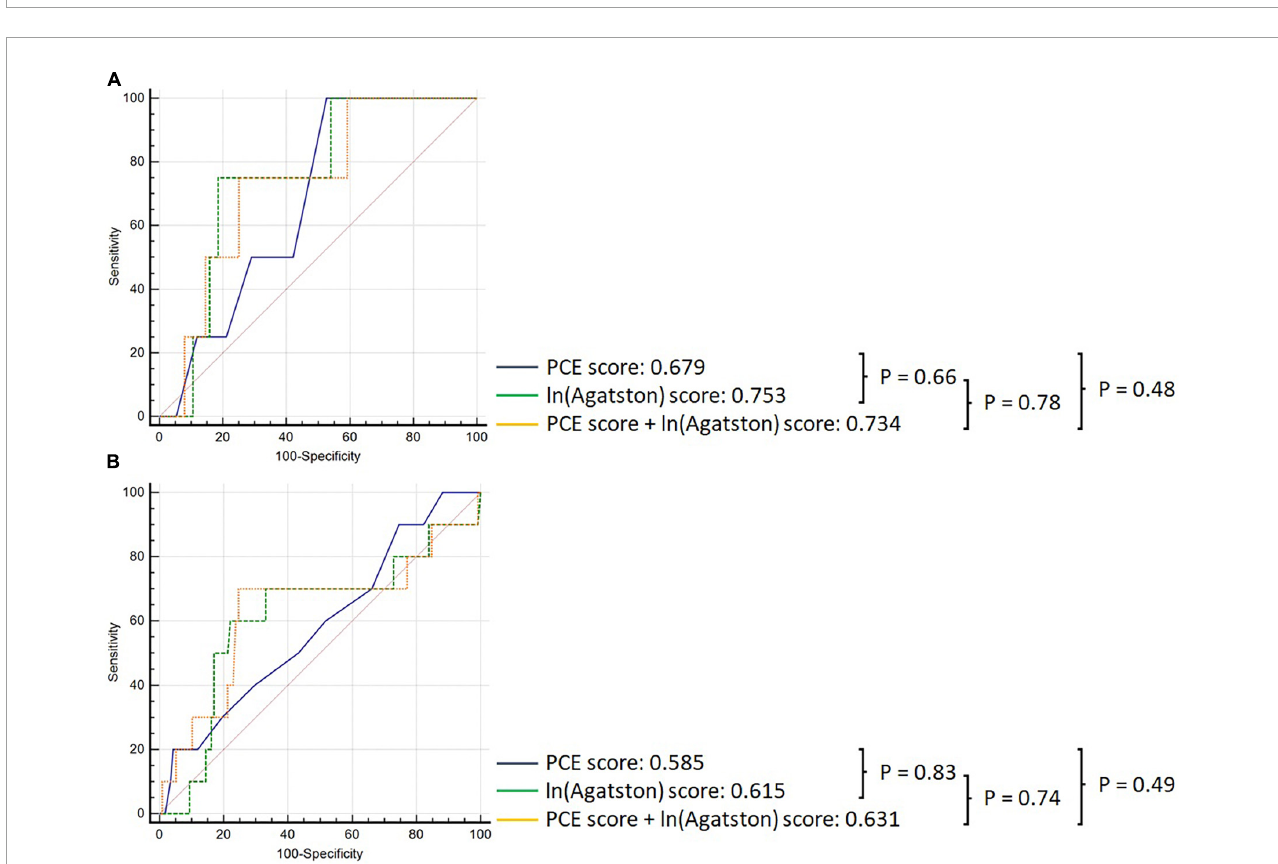
FIGURE3 Comparison of ROC curves demonstrating discrimination of the PCE (black), Agatston score (green), and PCE + Agatston score (yellow) models in predicting MACE, in panel (A) non-statin-prescribed participants, and (B) in statin-prescribed